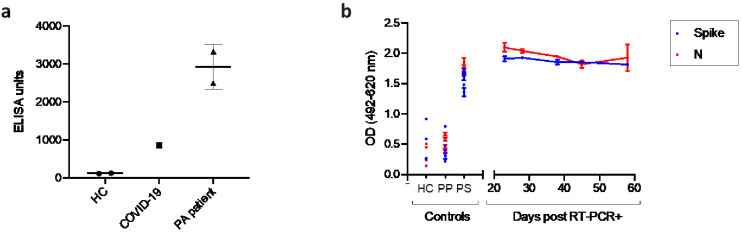
Antibody response towards Pseudomonas aeruginosa and SARS-CoV-2.(a) Serum IgG response to Pseudomonas aeruginosa (PA) protein outer membrane porin F (OprF) was assessed in healthy controls (n = 2), in the COVID-19 patient (n = 1) and in patients with diagnosis of Cystic Fibrosis and PA infection in the lung (PA patient, n = 2). Data are presented as mean ± SD. (b) Plasma IgG responses to SARS-CoV-2 Spike and N were assessed in the COVID-19 patient at five timepoints. For reference we also show levels from serum of healthy control donors (HC; n = 5), healthy pre-pandemic control donors (PP; n = 6) and a pooled serum (PS; n = 3) control per plate (collected from 3 RT-PCR-confirmed convalescent donors). The optical density (OD) at 492 nm was corrected for background (620 nm) and for the blank values. Data are presented as mean ± SD.